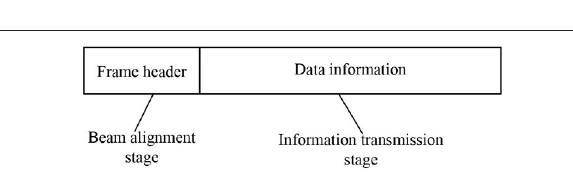
FIGURE 2 | Construction of data